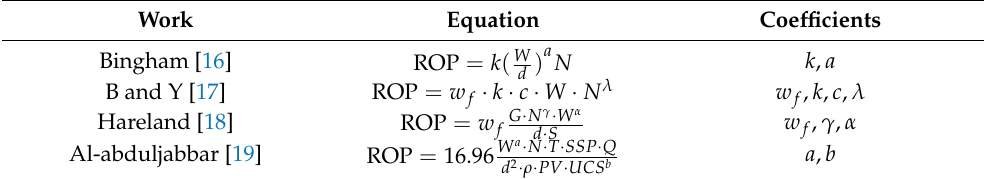
Table 3. Traditional ROP equations and